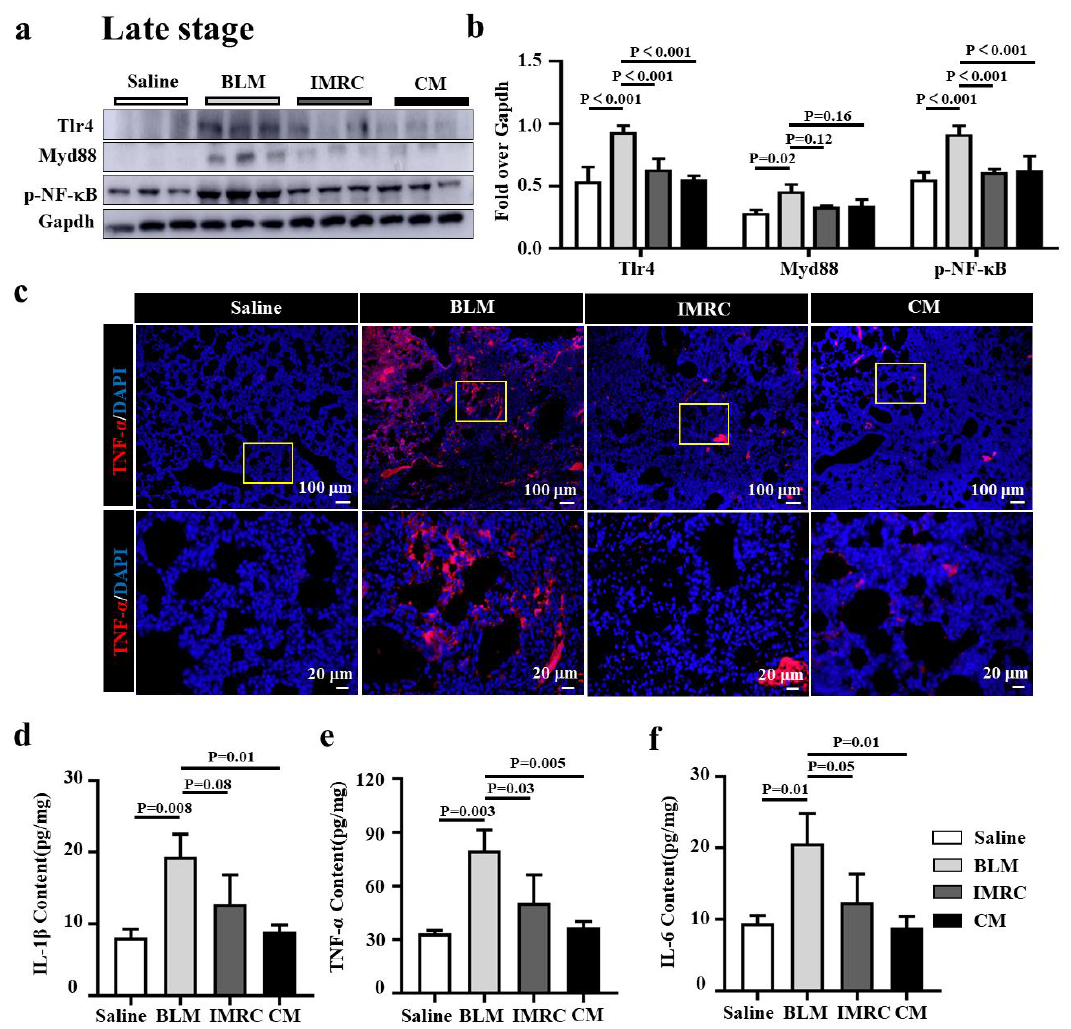
Figure 7. hESC-MSC-IMRCs and hESC-MSC-IMRC-CM attenuate inflammation in mice in the progressive stage of PF. ( a ) Representative immunoblots showed a reduction of molecules in the Tlr4/MyD88 signaling cascade in BLM-injured lungs administrated with hESC-MSC-IMRC-CM or hESC-MSC-IMRCs at d7, d14, and d21 after the first dose of BLM challenge, compared to BLM injury alone. ( b ) The relative levels of Tlr4, MyD88, and p-NF- κ B proteins as evaluated by a densitometric